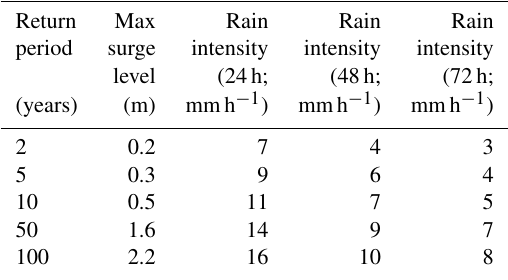
Table 3. Hydraulic boundary conditions for FLORES application in Beira. Note that the maximum surge level is calculated above the still-water level. Other factors like the tide (3.4m amplitude) and the mean sea level (3.6m + CD) should also be taken into account. The FLORES model will assume a storm duration of